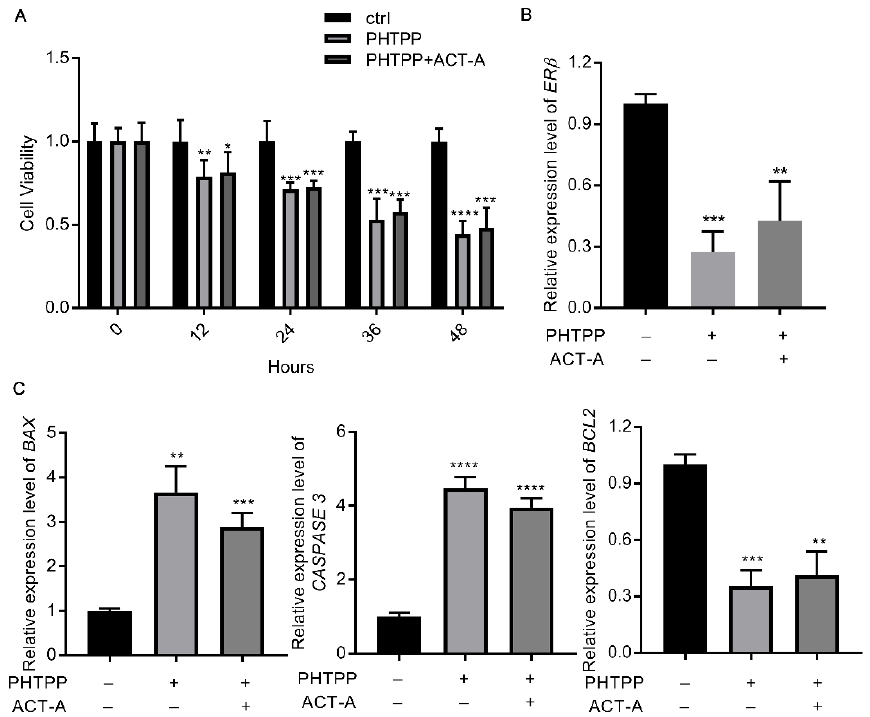
Figure 3. ACT-A mediates GCs apoptosis via modulation ER β expression. ( A ). The CCK-8 test was used to determine how PHTPP affected the apoptosis of GCs. B. C. Er β . ( B ). BAX , CASPASE 3 , and BCL2 ( C ). The gene expression levels were assessed by qRT-PCR. * p < 0.05, ** p < 0.01, *** p < 0.001, **** p < 0.0001.